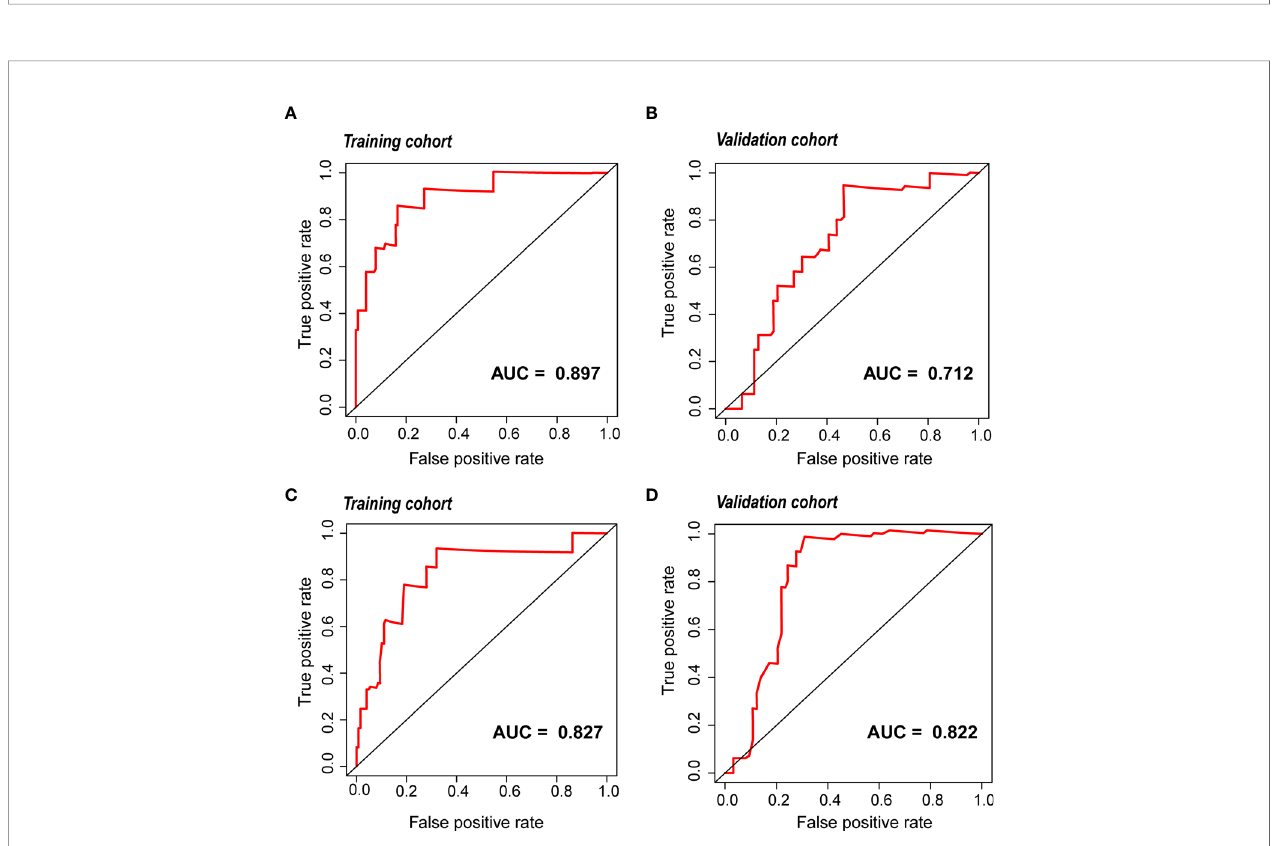
FIGURE 5 | The ROC curve of the radiomic and clinical signature. (A, B) The ROC of the radiomic signature in the training cohort and the validation cohort. (C, D) The ROC of the clinical signature in the training cohort and the validation cohort. ROC, relative operating characteristic curve